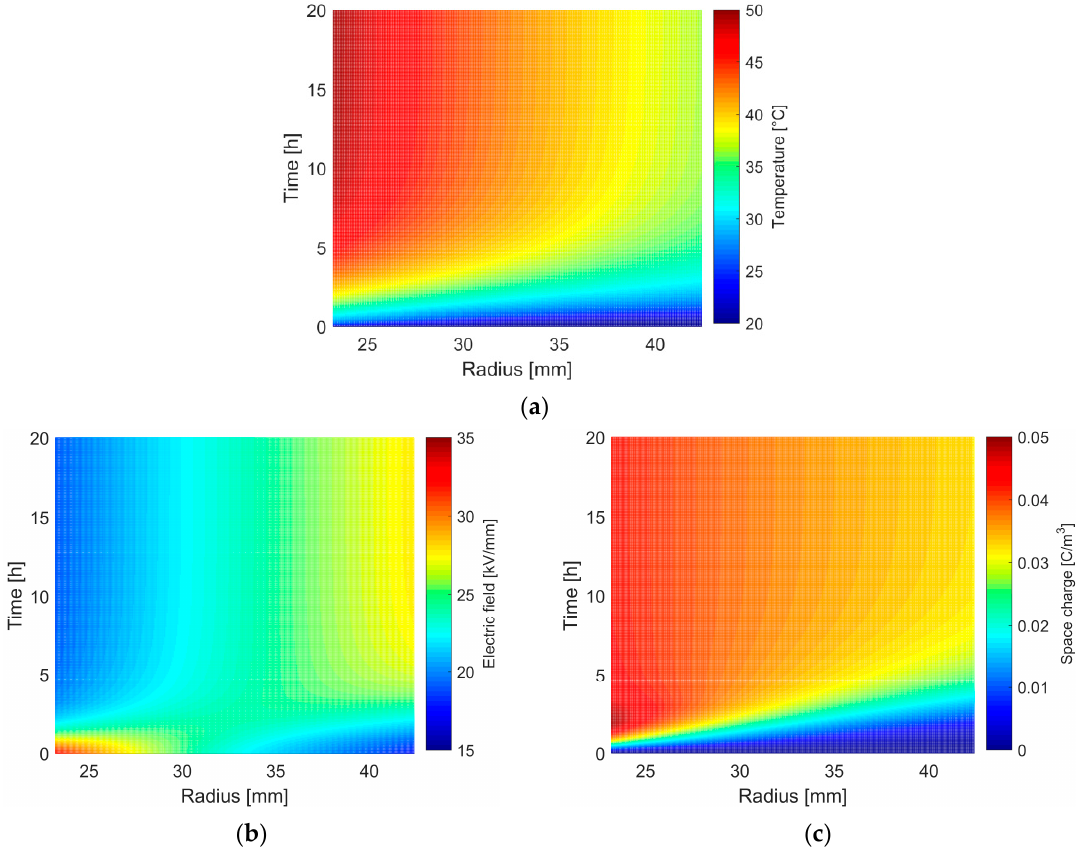
Figure 6. ( a ) Transient temperature distribution within a MI insulation; ( b ) corresponding transient electric field stress; ( c ) corresponding transient space charge density.